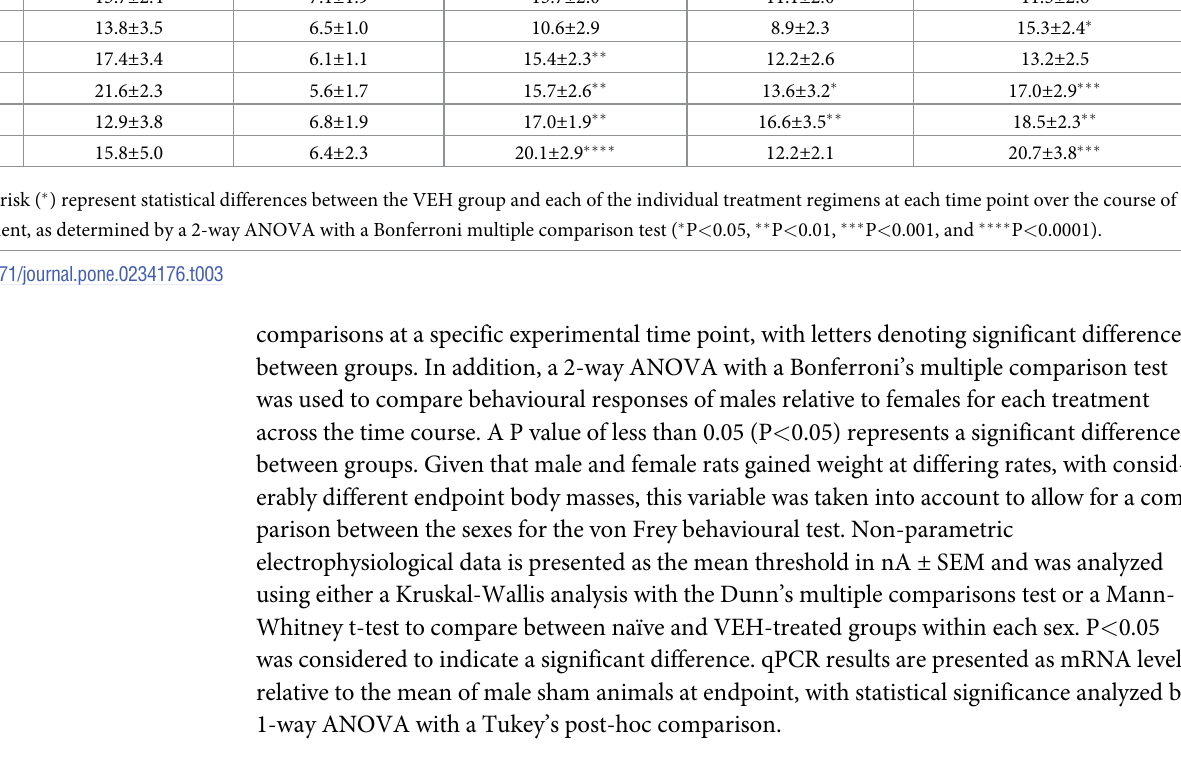
Von Frey data is summarized in Table 3 for males and Table 4 for females, which also list any specific significant differences within a sex between the VEH and each cannabinoid treatment Table 4. Female von Frey behavioural data presented as the mean withdrawal force, in grams (g).